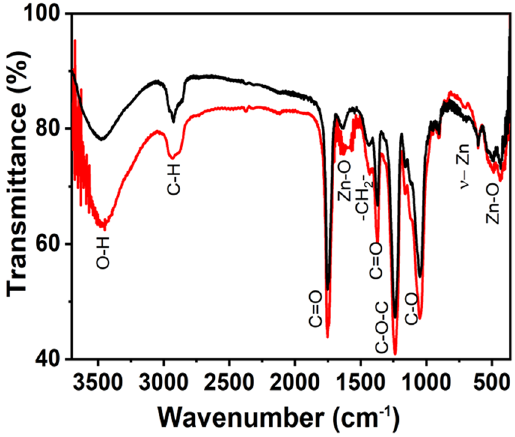
Figure 2. FTIR spectra of samples CA-ZnO (black line) and CA-ZnO-Ag (red line). The numbers indicate the corresponding assignments for the characteristic vibration energies (see text for